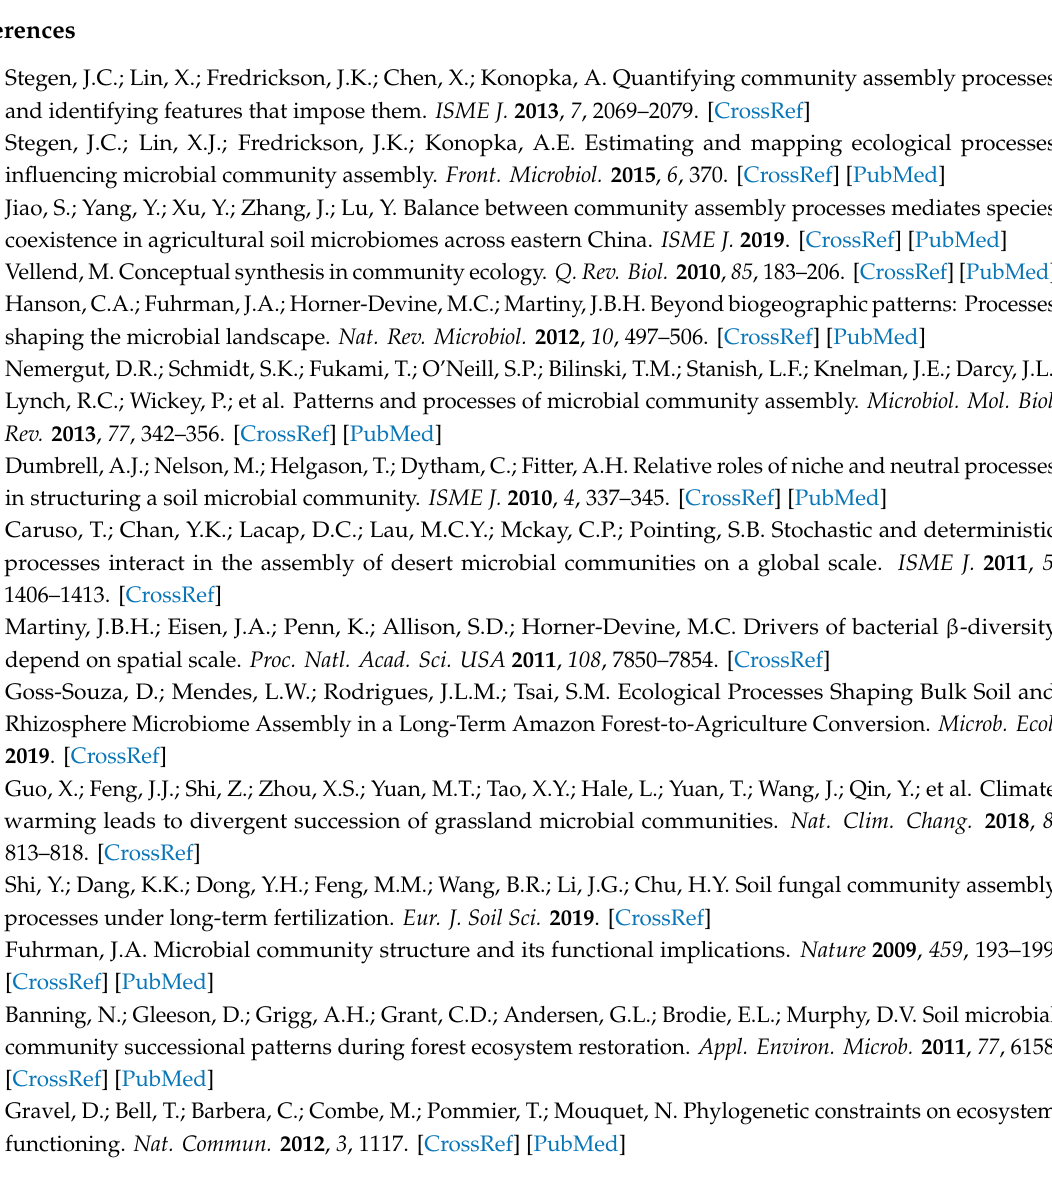
Tables S1–S4: Significance tests of the di ff erences of soil bacterial and fungal structure between each two of the four plantations, Tables S5 and S6: Properties of soil bacterial and fungal species co-occurrence networks, Figure S1: The layout of the studied plantations and the soil sampling scheme, Figure S2: Soil properties at three soil depths (0–10 cm, 10–30 cm, 30–50 cm) in the four studied plantations, Figure S3: The rarefaction curves of microbial OTU numbers, Shannon index and Chao index in relation to the number of reads for each sample, Figures S4 and S5: Spearman correlations of the top bacterial fungal phyla abundance with environmental variables, Figure S6: Non-metric multidimensional scaling (NMDS) ordination and principal coordinates analysis (PCoA) showing the structural di ff erences of bacterial and fungal communities along 0–50 cm soil profile in the four studied plantations. Author Contributions: Conceptualization, J.C.; methodology, J.C.; investigation, W.Z., J.Y. and H.X.; data